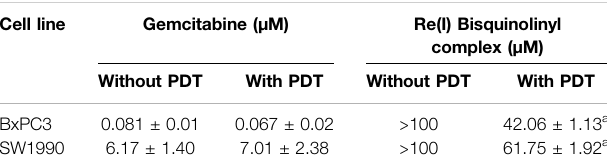
TABLE 2 | Half maximal inhibitory concentration (IC 50 ) values of gemcitabine and Re(I) bisquinolinyl complex with/without PDT in pancreatic cancer cell lines. Cell